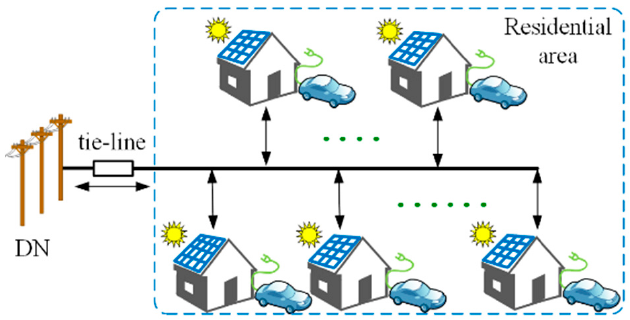
Figure 1. Conceptual schematic outline of the residential microgrid (RMG), where the solid black line with arrows represents power flow.